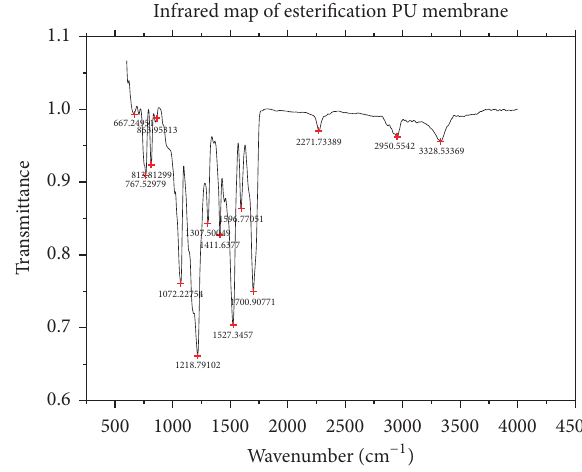
Figure 5: ATR-FTIR spectrum of esterification PU